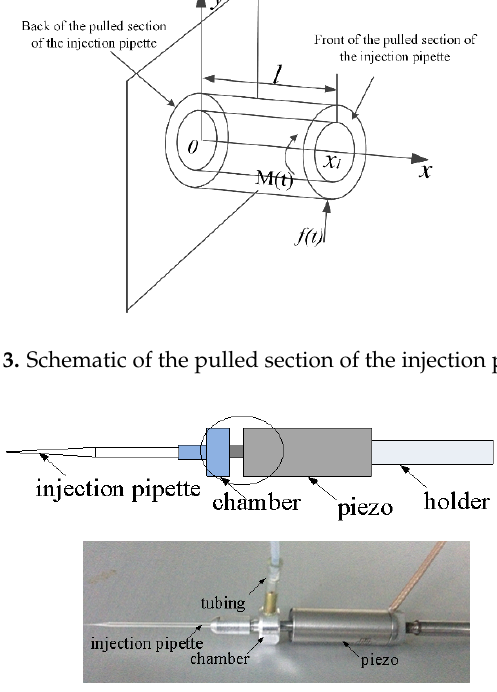
Figure 4. Structure of the first modified injector.